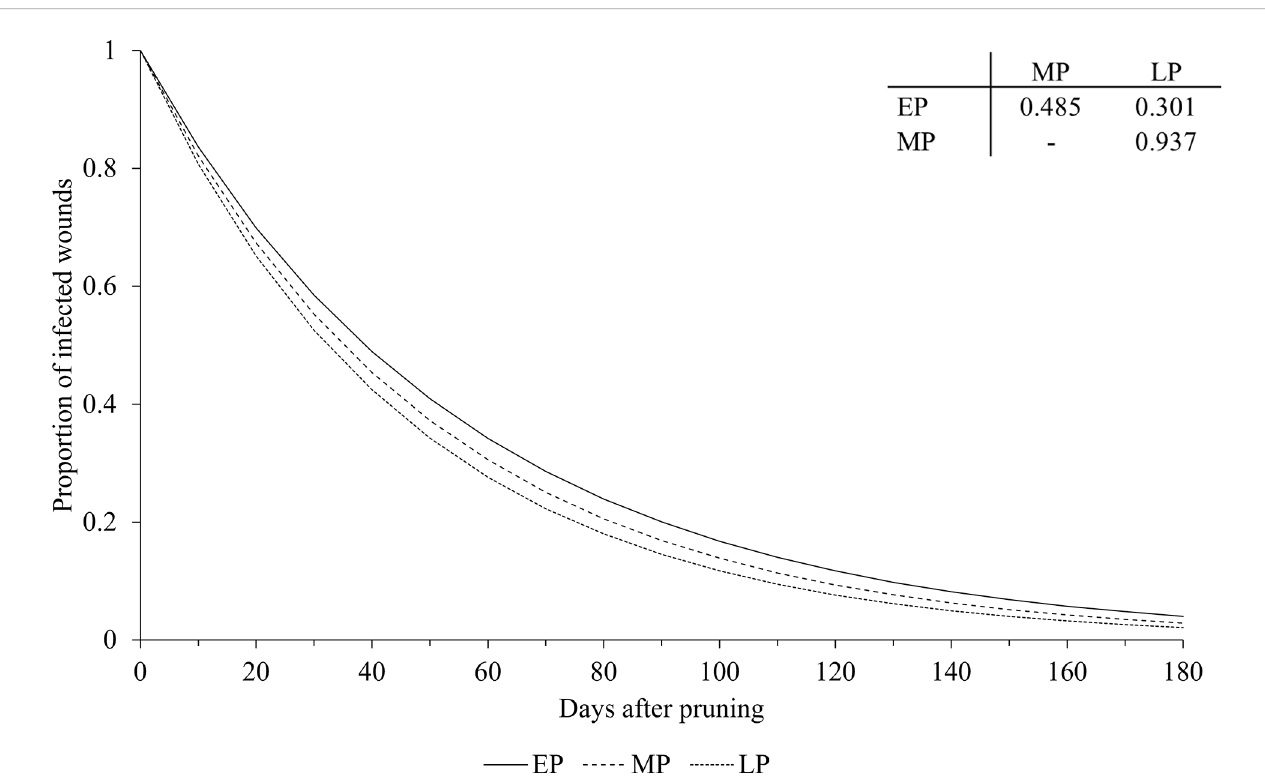
FIGURE 5 Effect of pruning period on the relationship between the proportion of pruning wounds that became infected (Y axis) and the time after pruning (DAP) when the wounds were arti fi cially inoculated with GTD fungi (X axis). Early pruning period (EP - full line), mid pruning period (MP - dashed line), and late pruning period (LP - dotted line). Lines were predicted by equation [1] (see text). The table shows the P values for the differences between the estimates of parameter a in equation [1] (see Table 2 for estimates of a for pruning